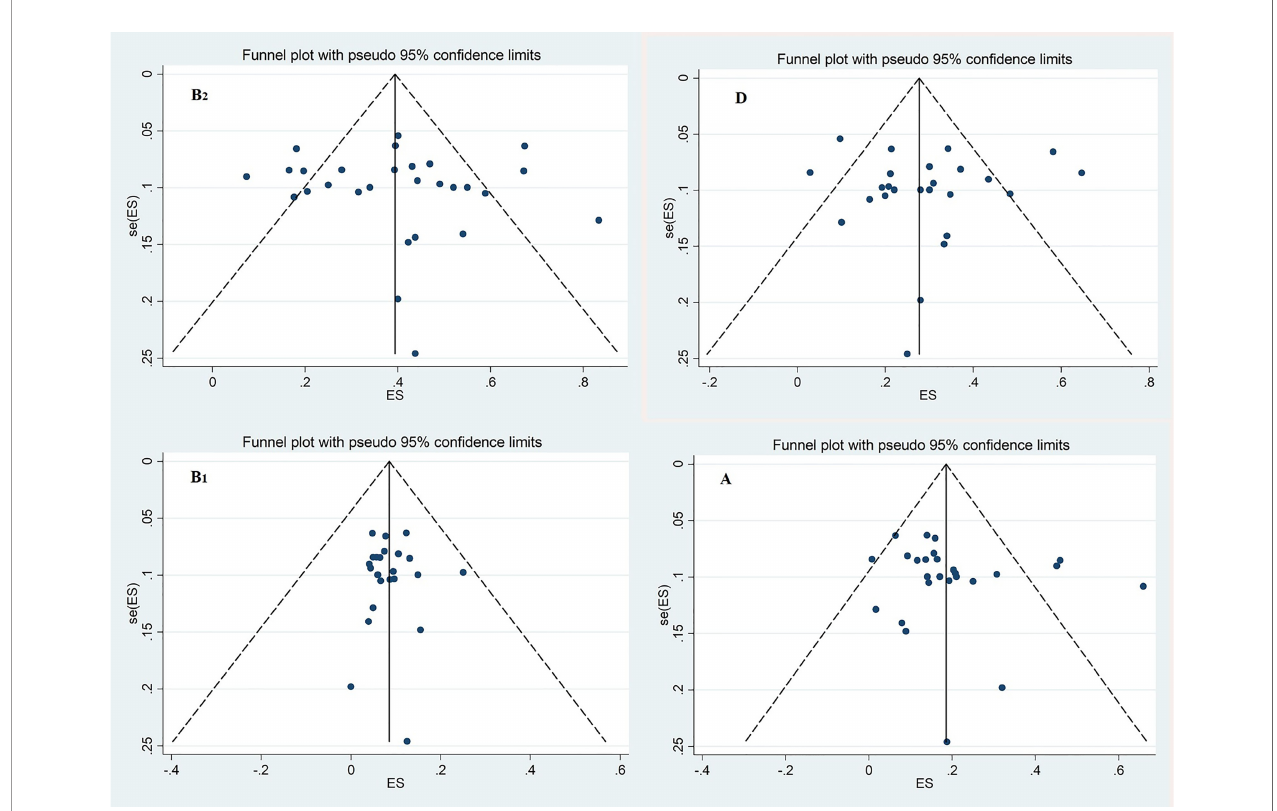
FIGURE 3 | Funnel plot for evaluation of publication bias; Phylogenetic groups B 2 , D, B 1 and